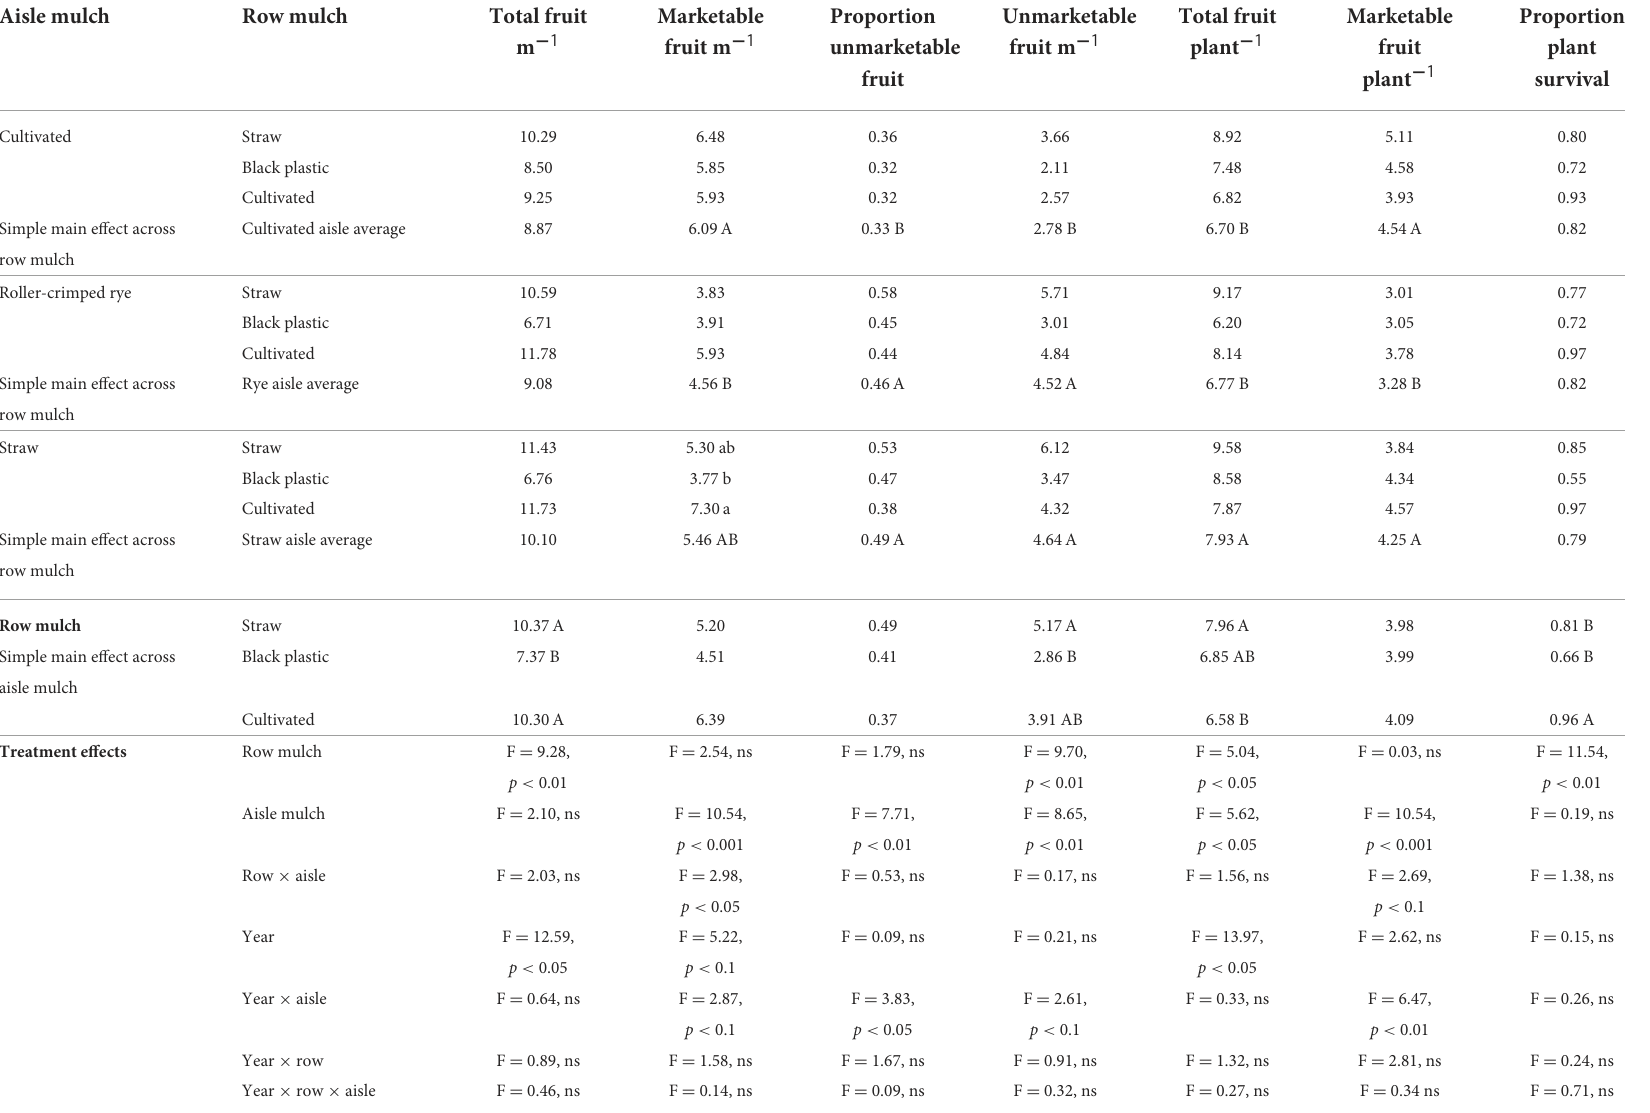
TABLE 3 Yield, quality, and survival data for organic squash managed with CCBRT by mulch treatment. Aisle